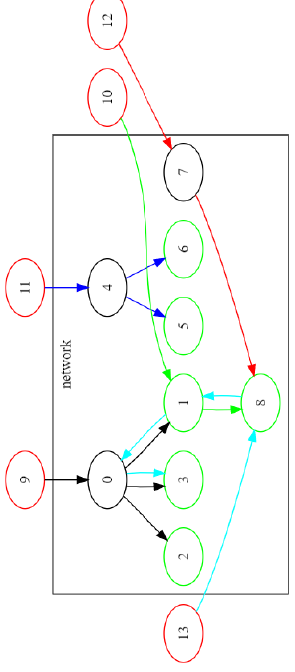
Figure 8. Instance res0